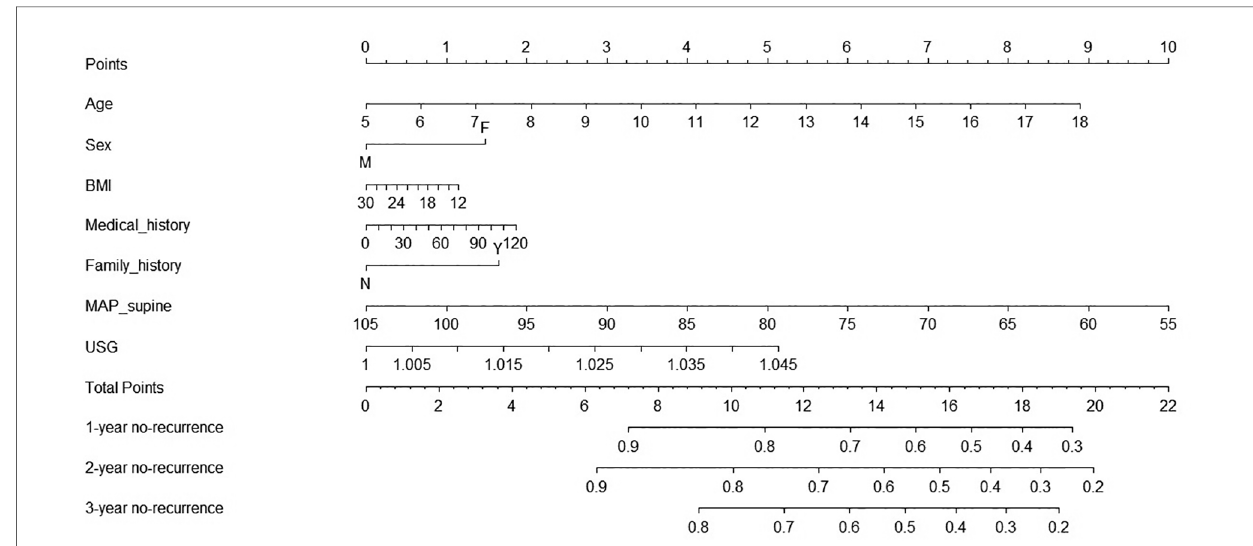
FIGURE 2 Prognostic nomogram of the prediction of signi fi cant parameters for 1-year, 2-year, and 3-year no-recurrence of vasovagal syncope among all study children. Abbreviations: F, female; M, male; Y, with family history of syncope; N, without family history of syncope; BMI, body mass index; MAP, average arterial pressure; USG, urine speci fi c